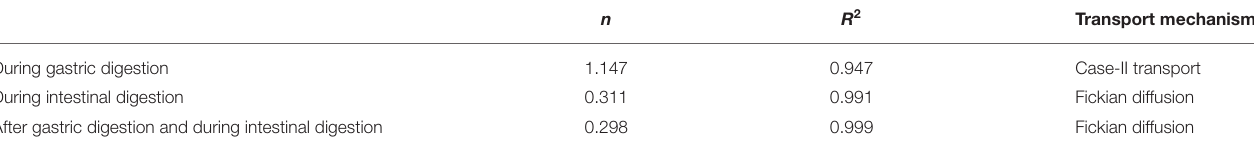
TABLE 3 | Diffusional exponent ( n ), correlation coefficient ( R 2 ), and the transport mechanism of thymoquinone release profile.